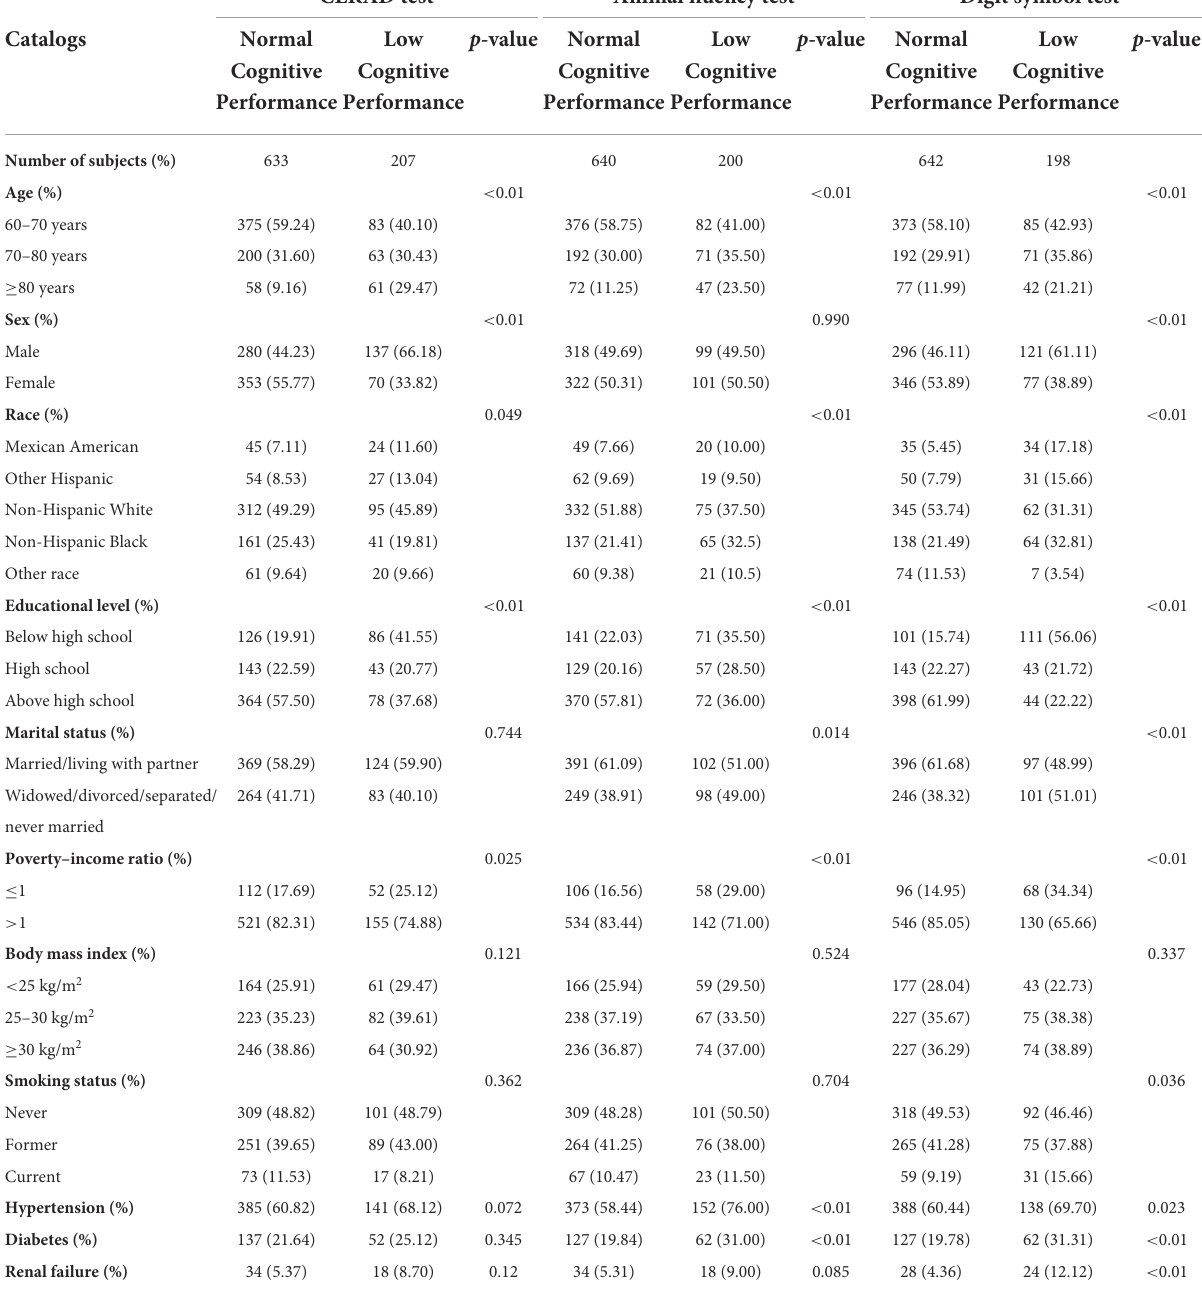
TABLE 1 Characteristics of the study population, National Health and Nutrition Examination Survey (NHANES) 2011–2014 ( N = 840). CERAD test Animal fluency test Digit symbol